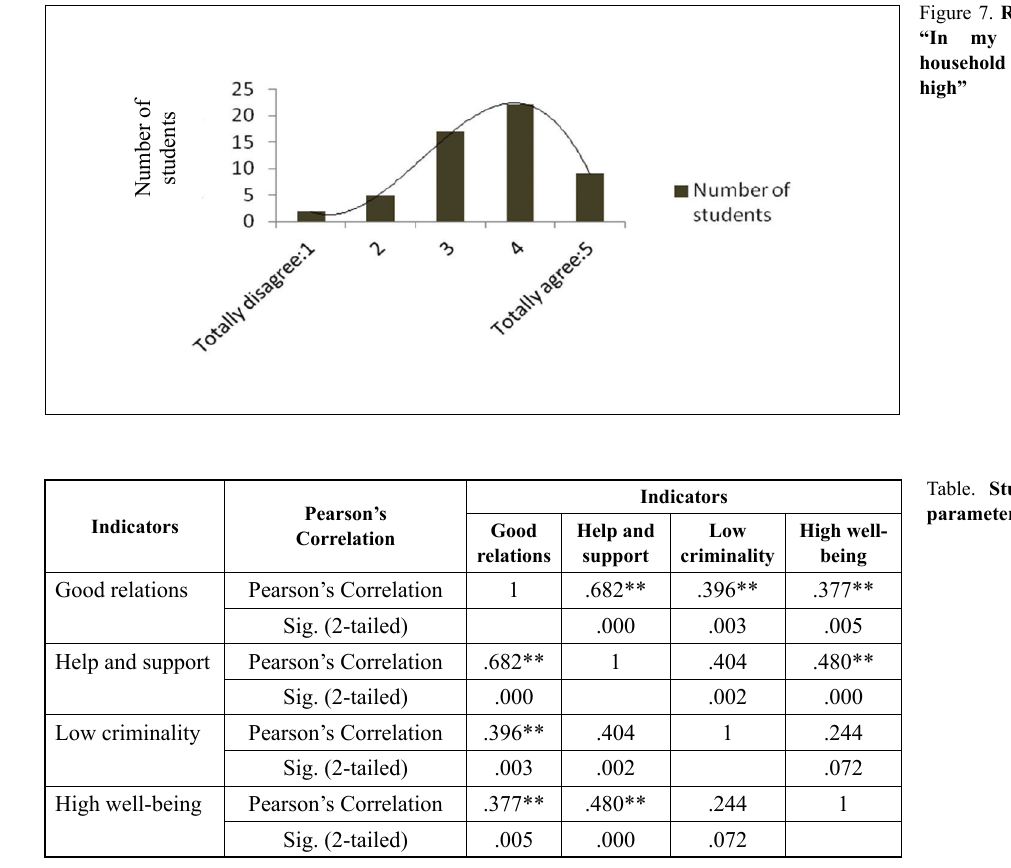
Figure 7. Response to